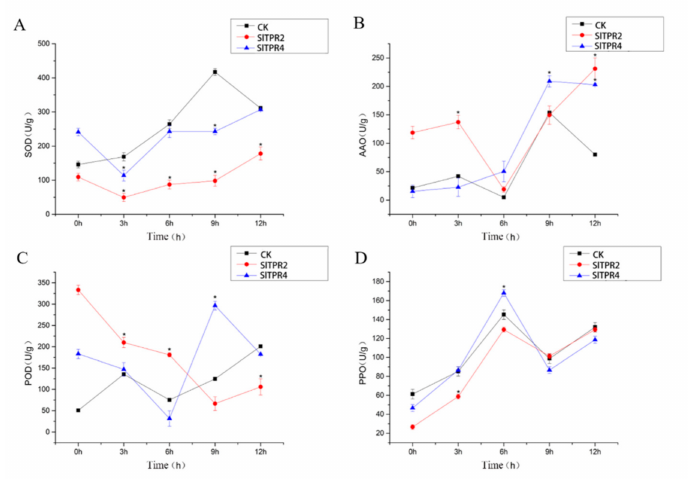
Figure 6. Effects of drought stress on the SOD ( A ), AAO ( B ), POD ( C ), PPO ( D ) in control and SlTPR2 , SlTPR4 silenced tomato. Error line indicate the standard deviation of three independent biological replicates. ANOVA was used for significance analysis. “*” represents a significant difference between the data point and control ( p < 0.05).